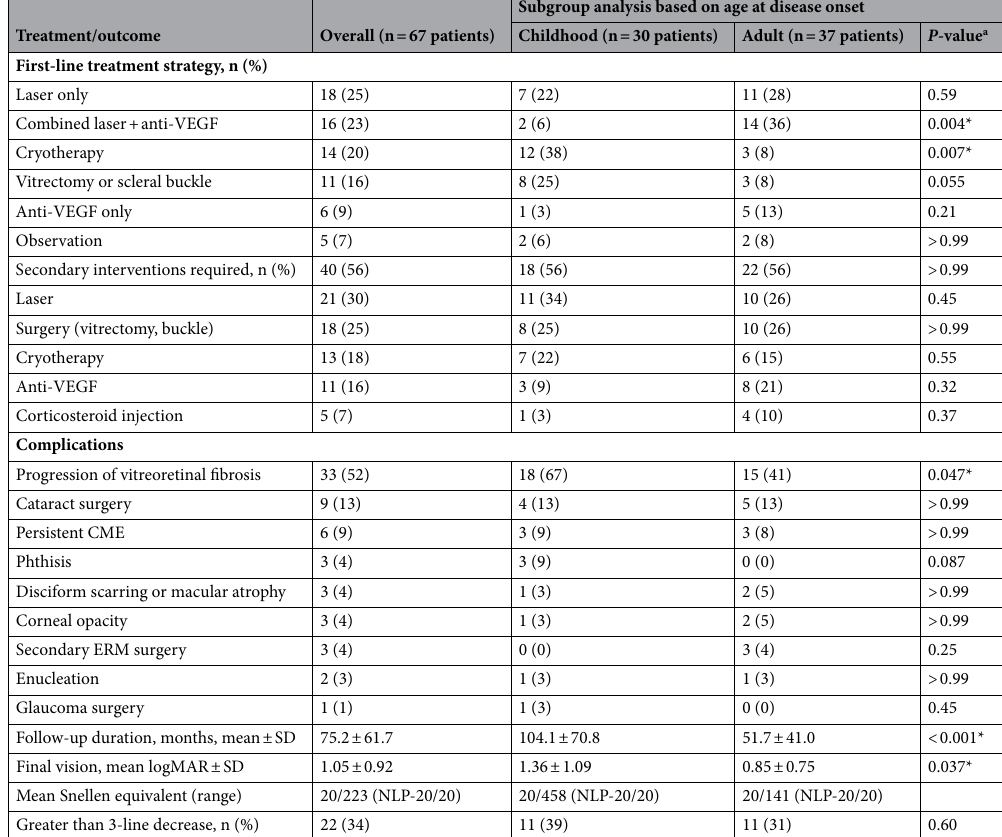
Table 3. Treatment and outcomes of patients with Coats’ disease. CME cystoid macular oedema, ERM epiretinal membrane, TRD tractional retinal detachment, VEGF vascular endothelial growth factor. * P -values of < 0.05 are considered statistically significant. a The chi-squared test and Student’s